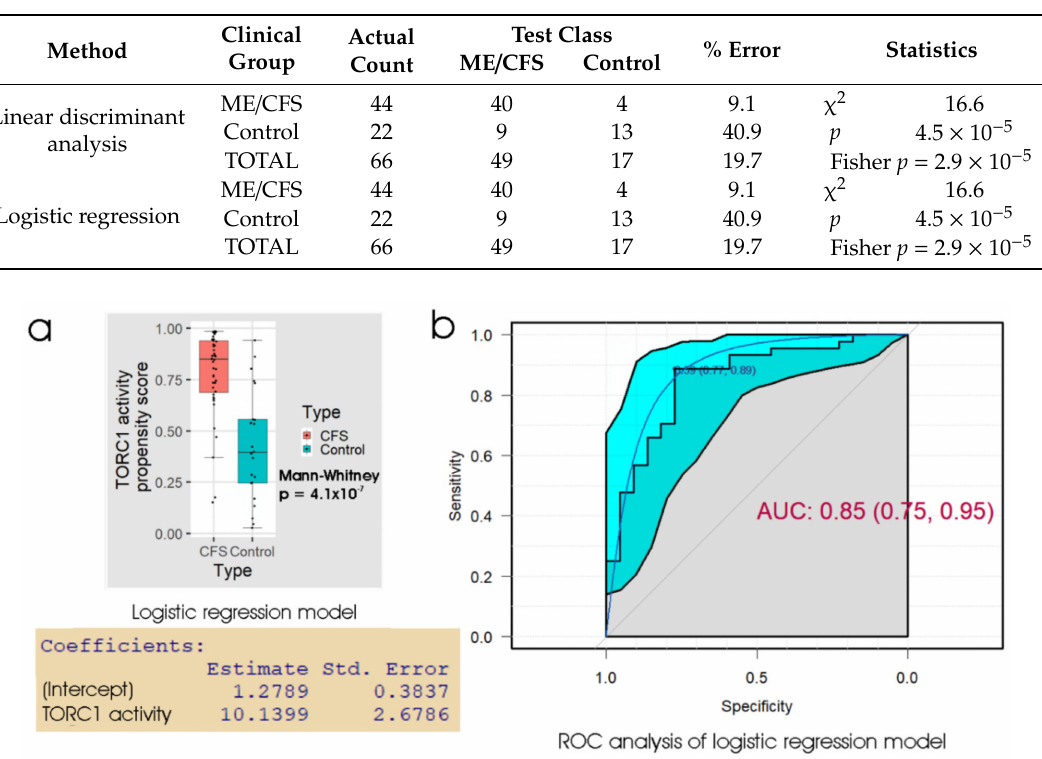
Figure 5. Logistic regression and ROC analysis of lymphoblast TORC1 activity. ( a ) Box plot showing the distribution of the propensity score from logistic regression of participant type against the logarithm of the relative TORC1 activity, measured as phosphorylation state of 4E-BP1 (a specific cellular target of TORC1). The resulting regression coe ffi cients are as indicated. The boxes show the median and the 25 th and 75 th percentiles, so that the height of the box is the interquartile range (IQR). The whiskers extend to the most extreme observations (largest and smallest) falling within ± 1.5 × IQR of the